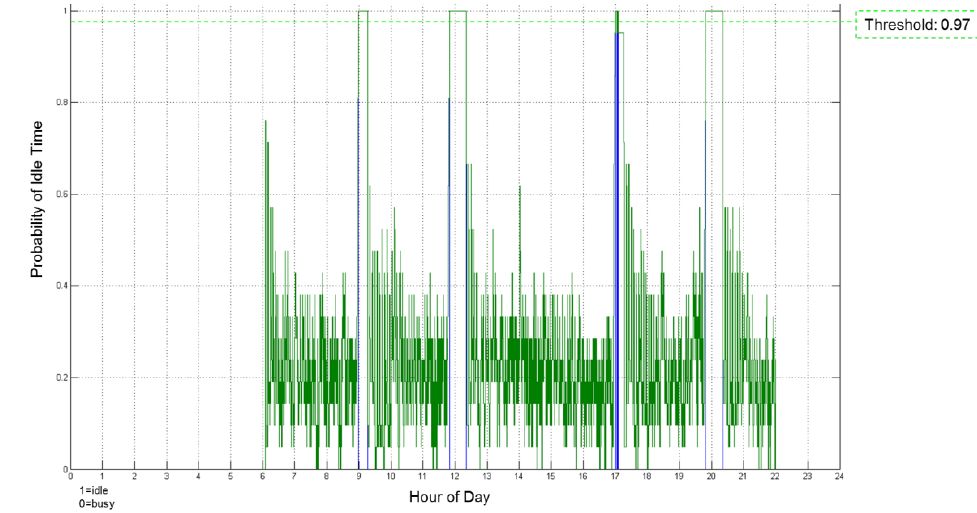
Figure 7. Example of detected machine idle times.